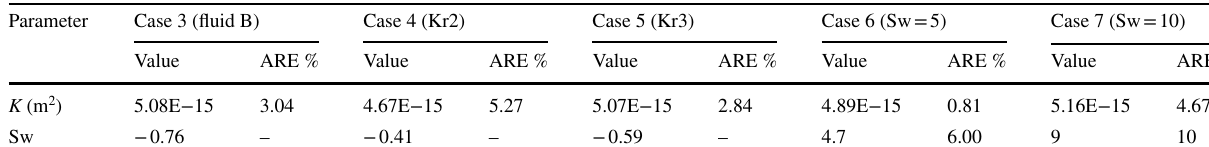
Table 5 Results of BU1 test using normalized two-phase pseudo-pressure in different cases Parameter